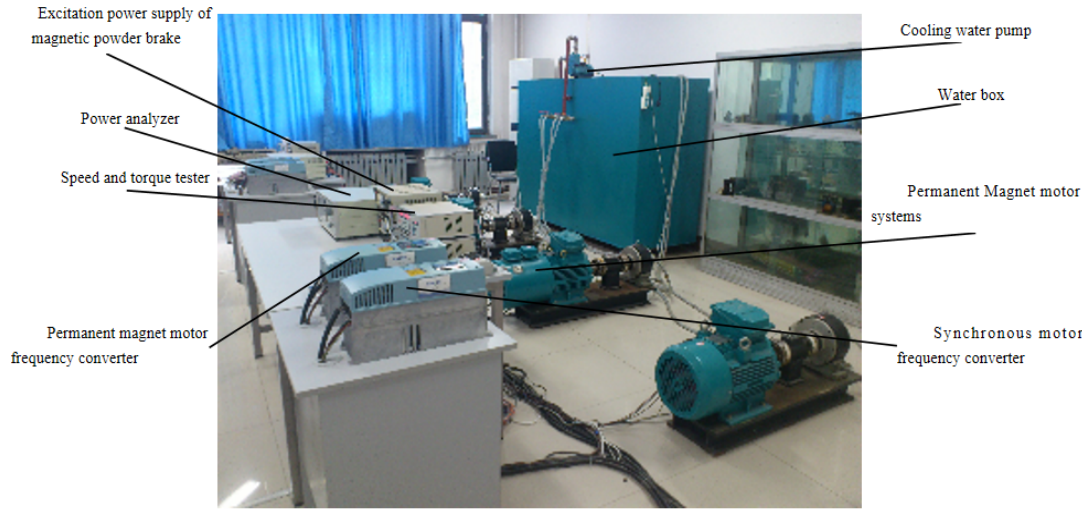
Figure 19. Prototype experiment platform.